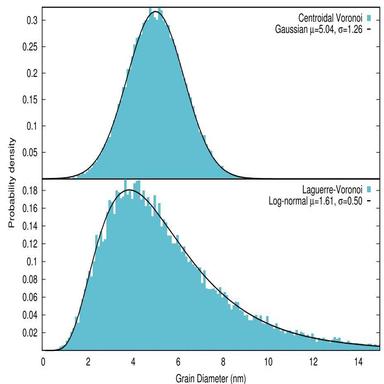
Grain diameter distributions for centroidal Voronoi tessellation (top) and Laguerre-Voronoi tessellation (bottom). The input distribution was lognormal with μ = 1.65 and σ = 0.55. The seed based Voronoi is unable to provide the desired distribution, instead providing a Gaussian. The Laguerre-Voronoi was able to produce the desired distribution type with only a small change of parameters, which is to be expected due to the random nature of the packing process.